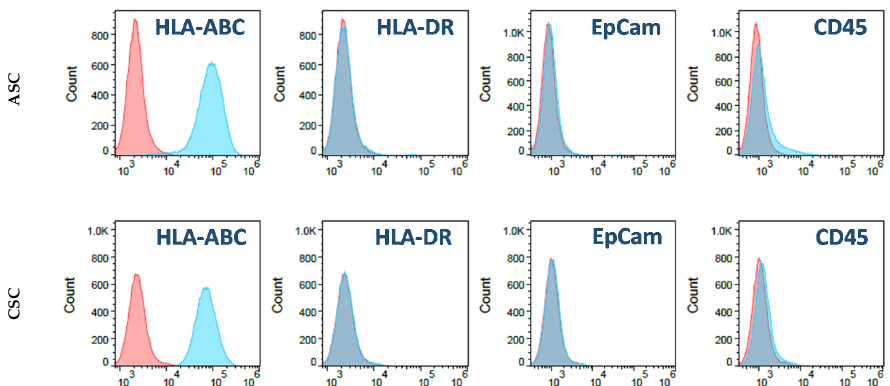
Figure 1. Characterization of amniotic stromal cells (ASCs) and chorionic stromal cells (CSCs). ( A ) Morphological appearance of ASCs and CSCs. A total of 5 × 10 5 isolated primary ASCs and CSCs were plated in T175 tissue culture plates, and pictures were taken on day 10 under a regular microscope. Scale bar = 100 μ M. ( B ) Flow cytometry analysis of cultured ASCs and CSCs for the indicated antibodies (blue) or their corresponding isotype control antibodies (red).